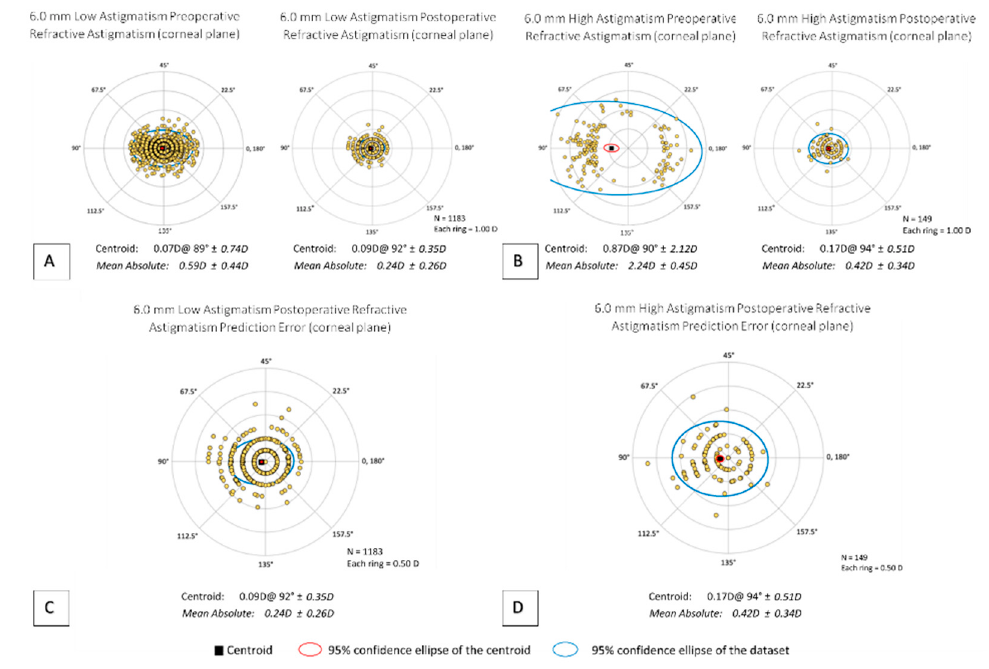
Figure 3. Vector analysis of 6.0 mm Low and High Astigmatism Subgroups. ( A ) Comparison of preoperative and postoperative refractive astigmatism for 6.0 mm Low Astigmatism; ( B ) comparison of preoperative and postoperative refractive astigmatism for 6.0 mm High Astigmatism; ( C ) postoperative refractive astigmatism prediction error for 6.0 mm Low Astigmatism; ( D ) postoperative refractive astigmatism prediction error for 6.0 mm High Astigmatism.